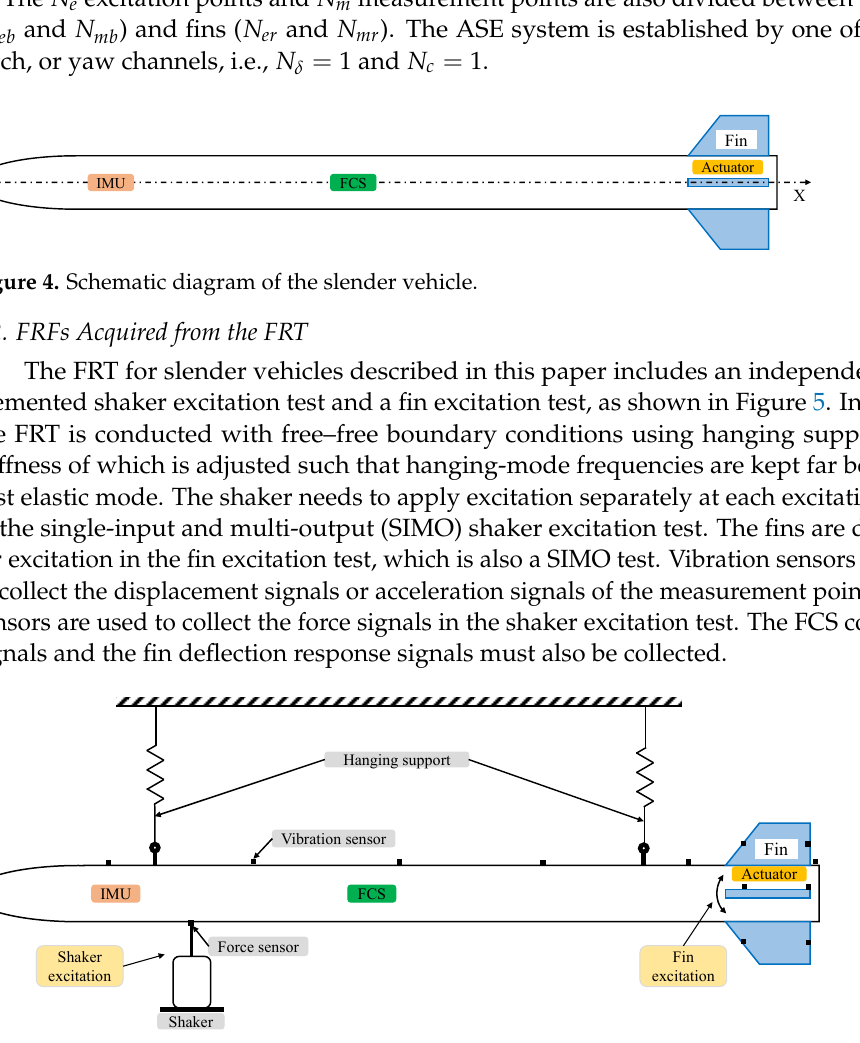
Figure 5. Schematic diagram of the